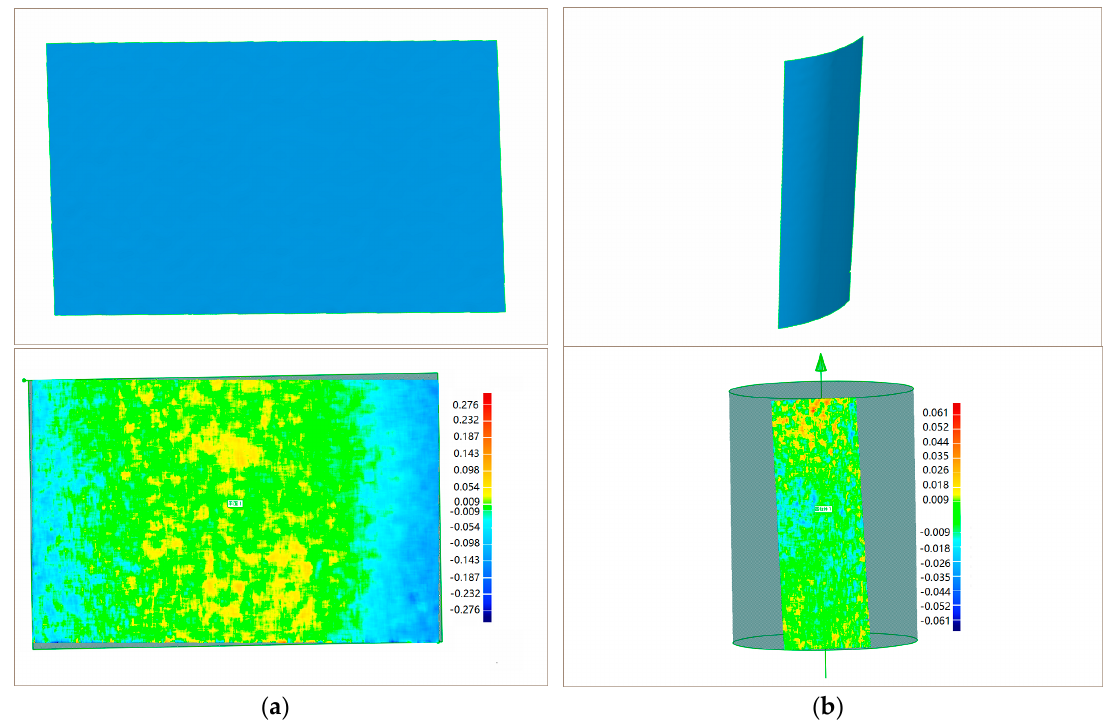
Figure 10. 3D shape measurement result and error distribution map: ( a ) plane surface; and ( b ) cylinder surface. Table 2. Comparisons of measurement results by CMM and PMS (unit: mm).